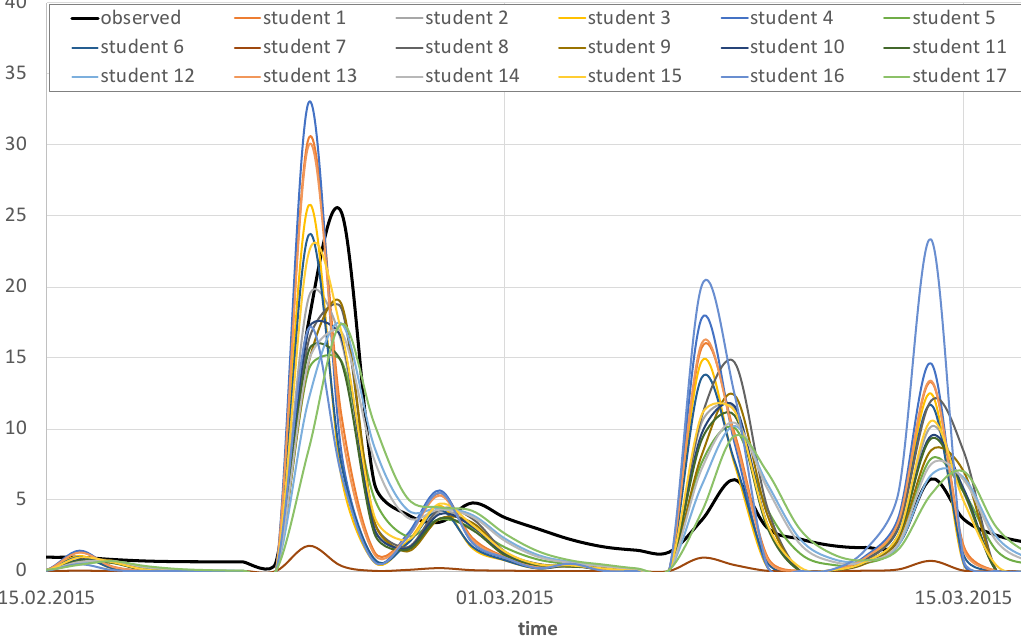
Figure 3. Variability of the discharges simulated by the different modellers against observations for three selected events in the rainy season of 2015.